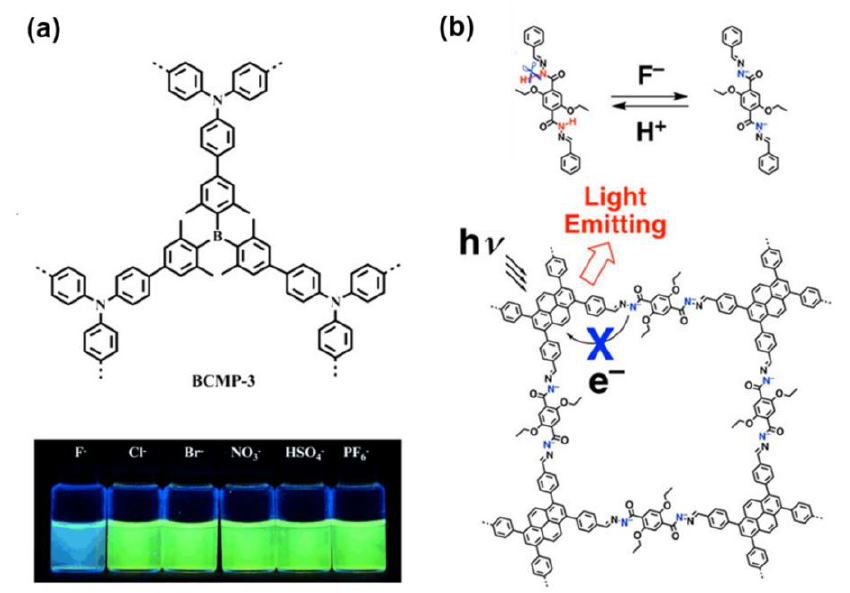
Figure 9. ( a ) BCMP − 3 for F − sensing [109]. Copyright 2015 John Wiley and Sons; ( b ) TFPPy − DETHz − COF for F − sensing [110]. Copyright 2018 American Chemical